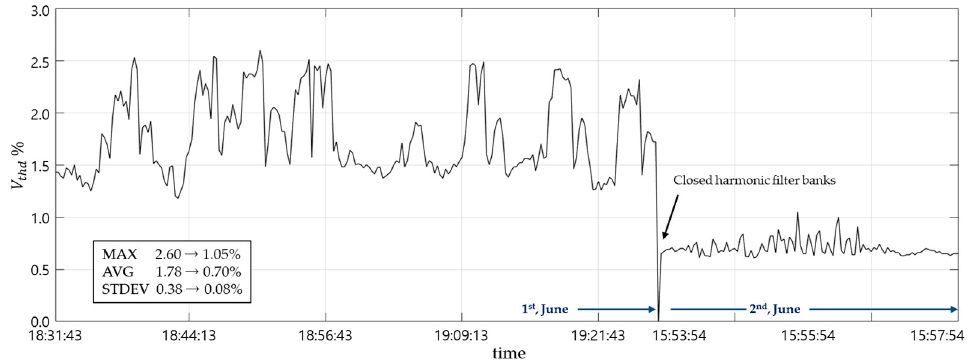
Figure 9. Measured 𝑉 (cid:3047)(cid:3035)(cid:3031) for 22 kV plate mill system. Figure 9. Measured V thd for 22 kV plate mill system.